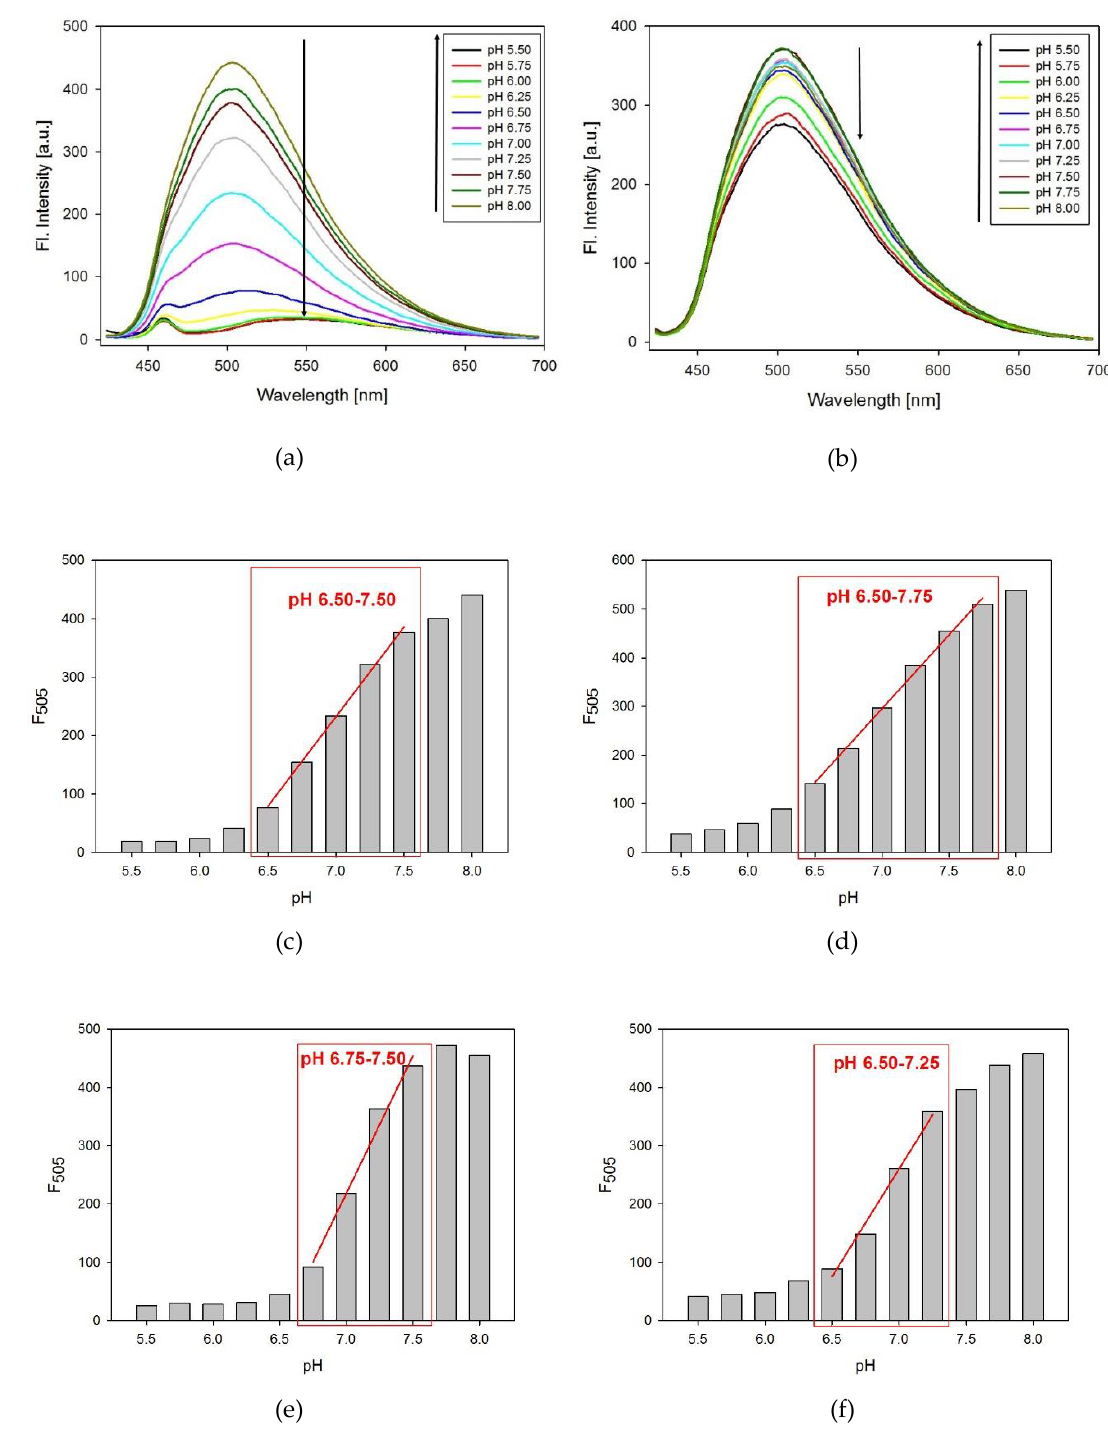
Figure 4. The emission spectra of the 8tC probe ( a ) and the TtC probe ( b ) in the pH range from 5.50 to 8.00. Panels ( c – f ) show pH working ranges for tC probes: 8tC ( c ), 14tC ( d ), 17tC ( e ), and 19tC ( f ). In all cases, the excitation wavelength was set at 395 nm.